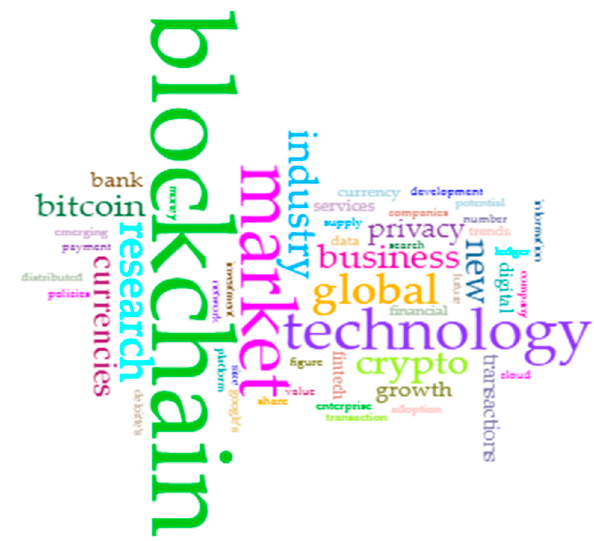
Figure 5. Resource map from textual analysis of industry